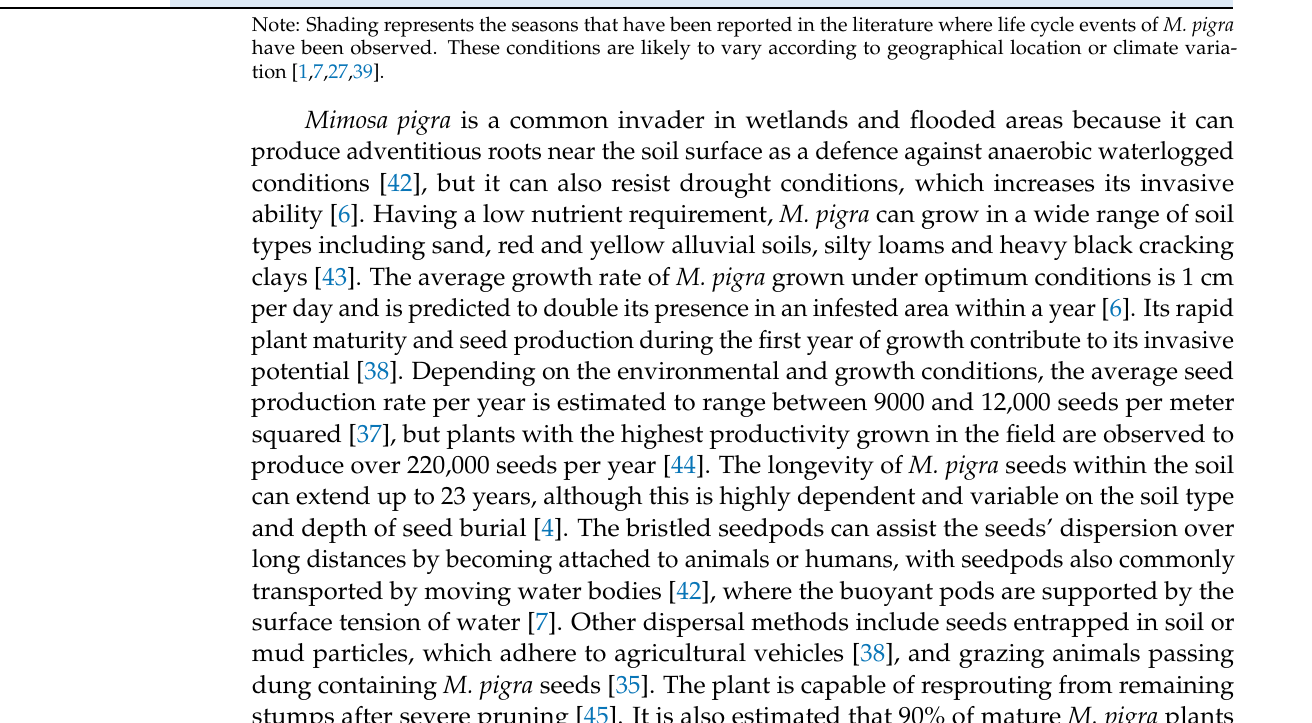
Table 1. Average life cycle of Mimosa pigra throughout each season. Plant Life Cycle Summer Autumn Winter Spring Seed Germination Flowering Podding Active Growth